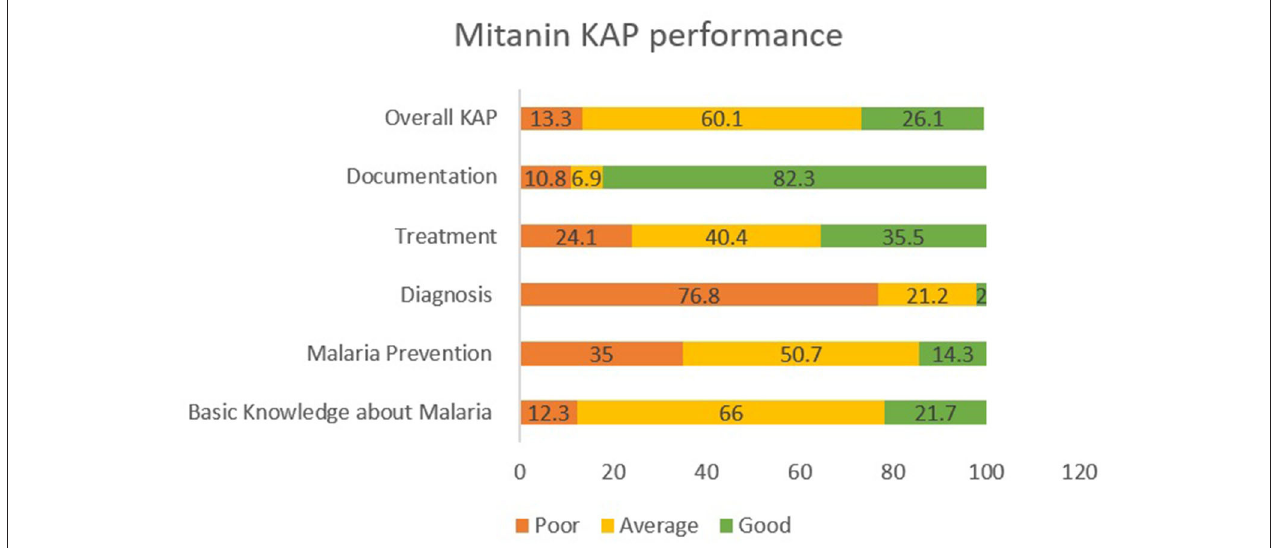
FIGURE 2 | Mitanin KAP Scores. The KAP score of mitanins in different sections and overall scores are highlighted in green (Good), Yellow (Average) and Orage (Poor). Malaria diagnosis, prevention and treatment were the three sections where frequency of low scoring was high.